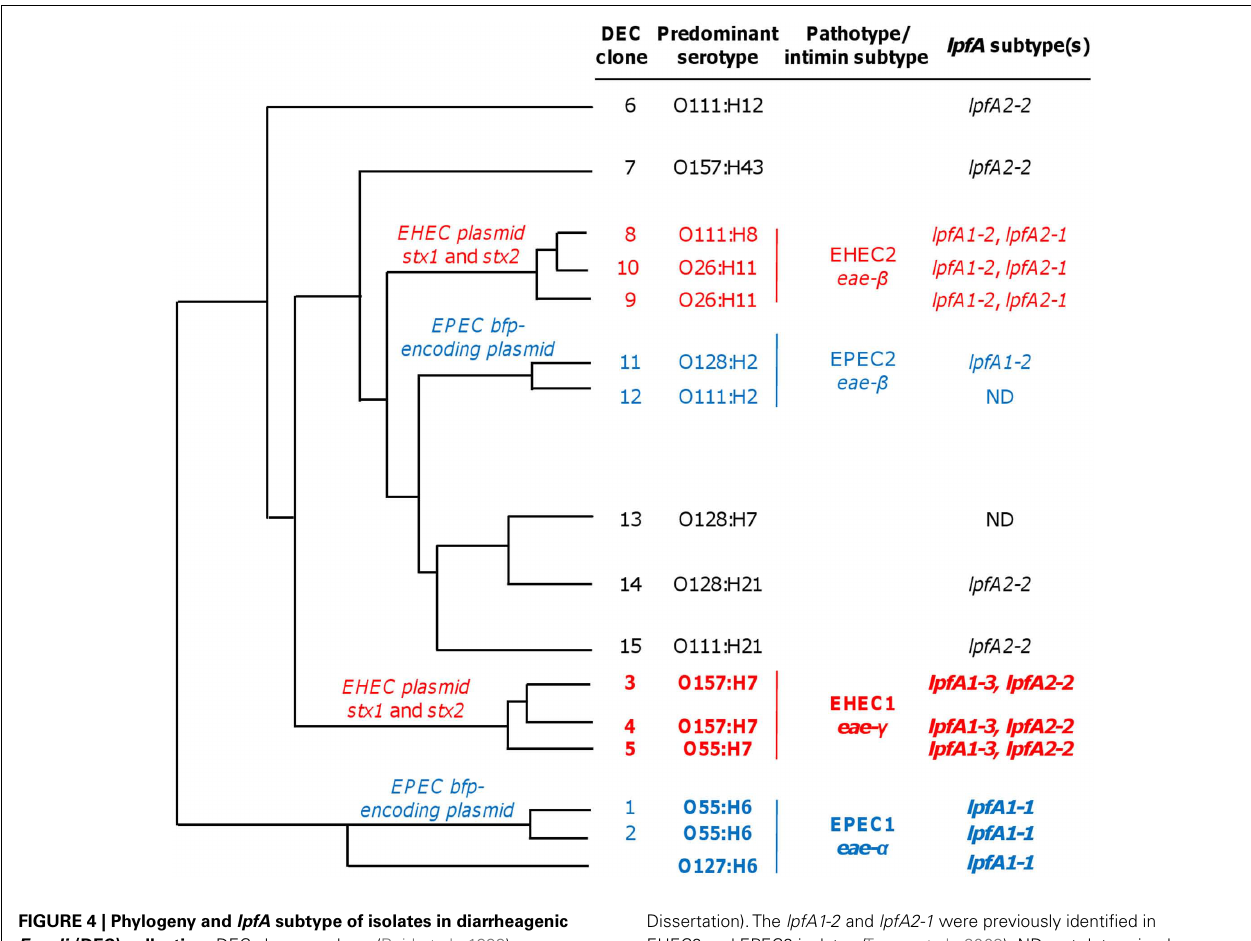
FIGURE 4 | Phylogeny and lpfA subtype of isolates in diarrheagenic E. coli (DEC) collection. DEC clone numbers (Reid et al., 1999), corresponding predominant serotype of the given group, pathotype/intimin subtype, and information regarding lpfA subtype(s) for each group are indicated (Adapted fromTorres, 1999